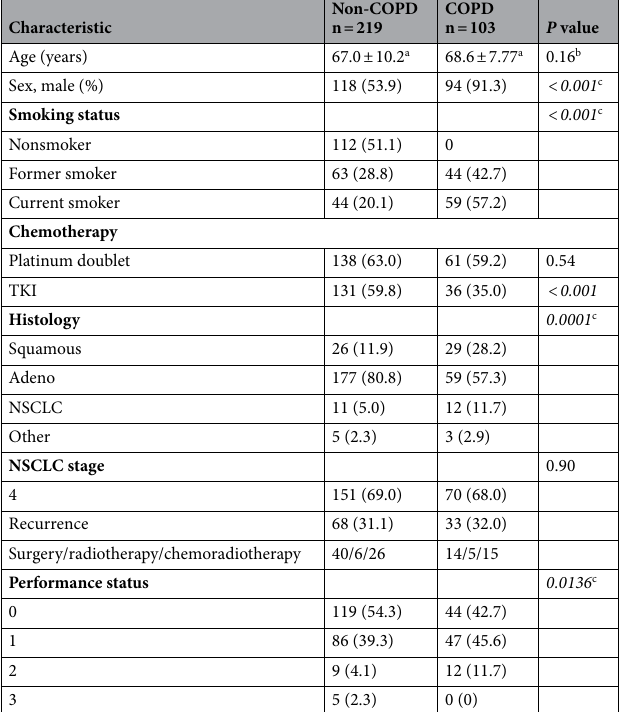
Table 1. Clinical characteristics of patients with advanced NSCLC. Continuous variables are presented as the mean, and categorical variables are presented as the number (%). Comparisons were made by means of chi-squared tests unless otherwise indicated. Significant values are in [italics]. TKI Tyrosine kinase inhibitors, NSCLC Non-small-cell lung cancer. a Mean ± SD. b Student’s t-test. c Fisher’s exact